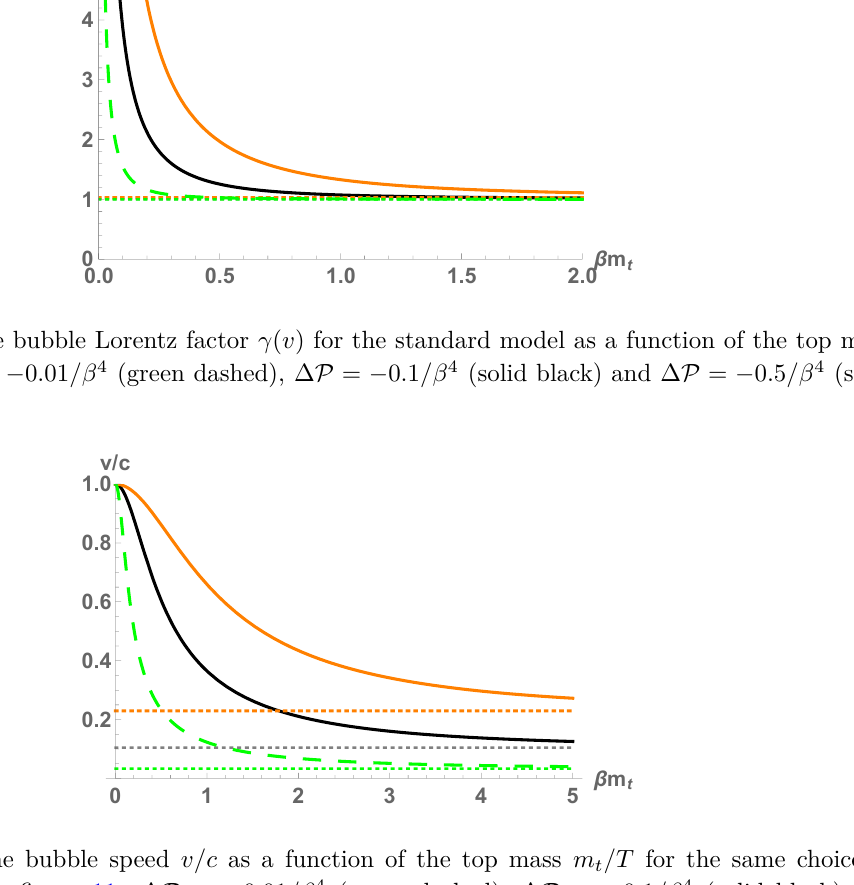
Figure 12 . The bubble speed v/c as a function of the top mass m t /T for the same choice of parameters as in figure 11: ∆ P = − 0 . 01 /β 4 (green dashed), ∆ P = − 0 . 1 /β 4 (solid black) and ∆ P = − 0 . 5 /β 4 (solid